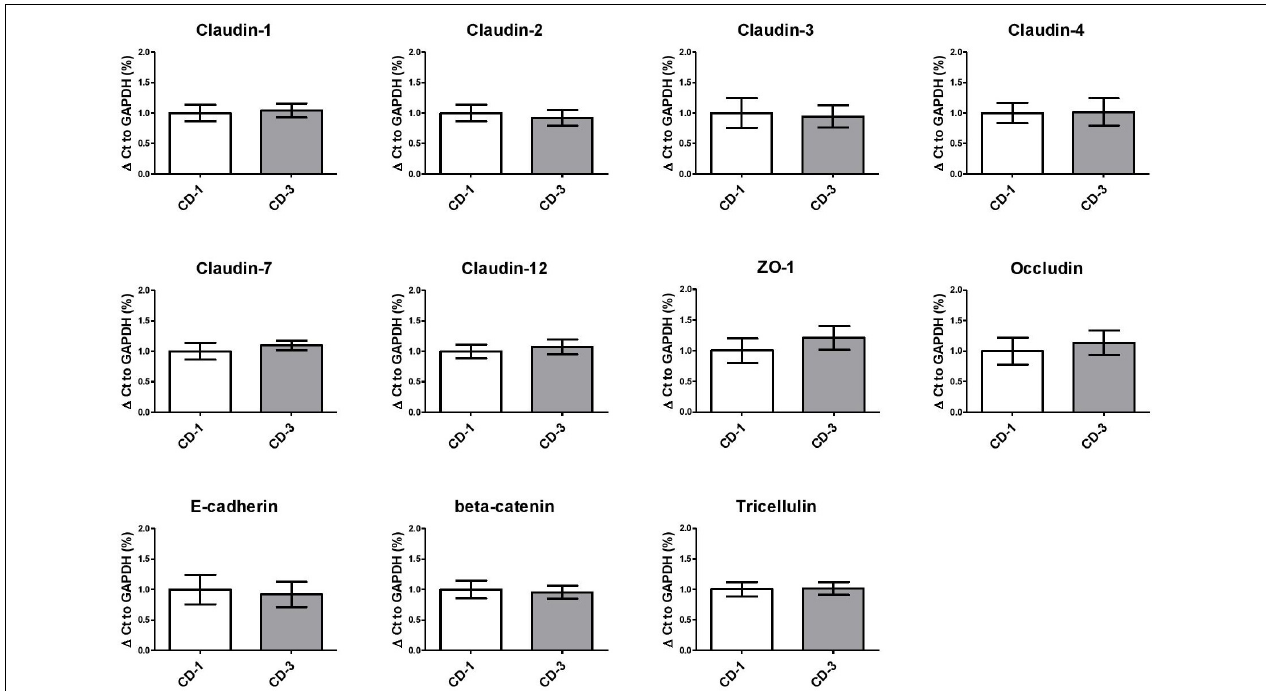
FIGURE 4 | Paracellular junction gene expression in Caco-2 cells exposed to B. fragilis culture supernatants remains unaltered. Tight junction (Claudins, ZO-1, Occludin), adherens junction (E-cadherin, beta-catenin) and tricellulin gene expression were unaltered in B. fragilis bft -positive CD-3 compared to bft -negative CD-1 culture supernatant. Means ± SD were based on two independent experiments. ZO-1, Zonulin 1.